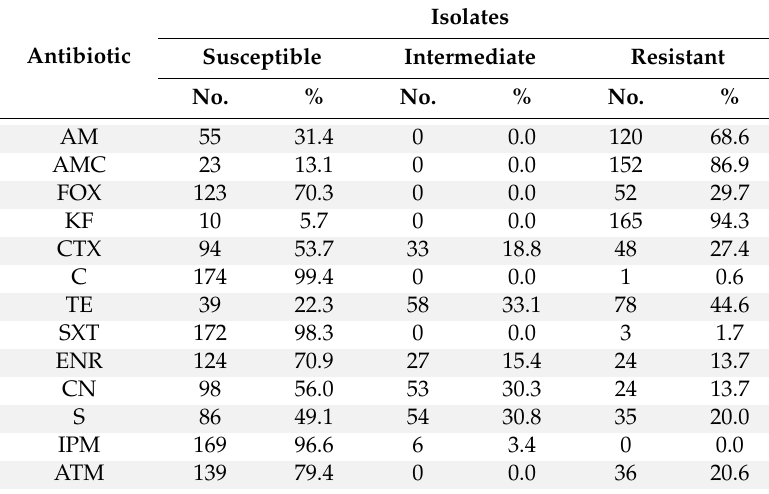
Table 3. Antimicrobial resistance in E. coli isolates from wild